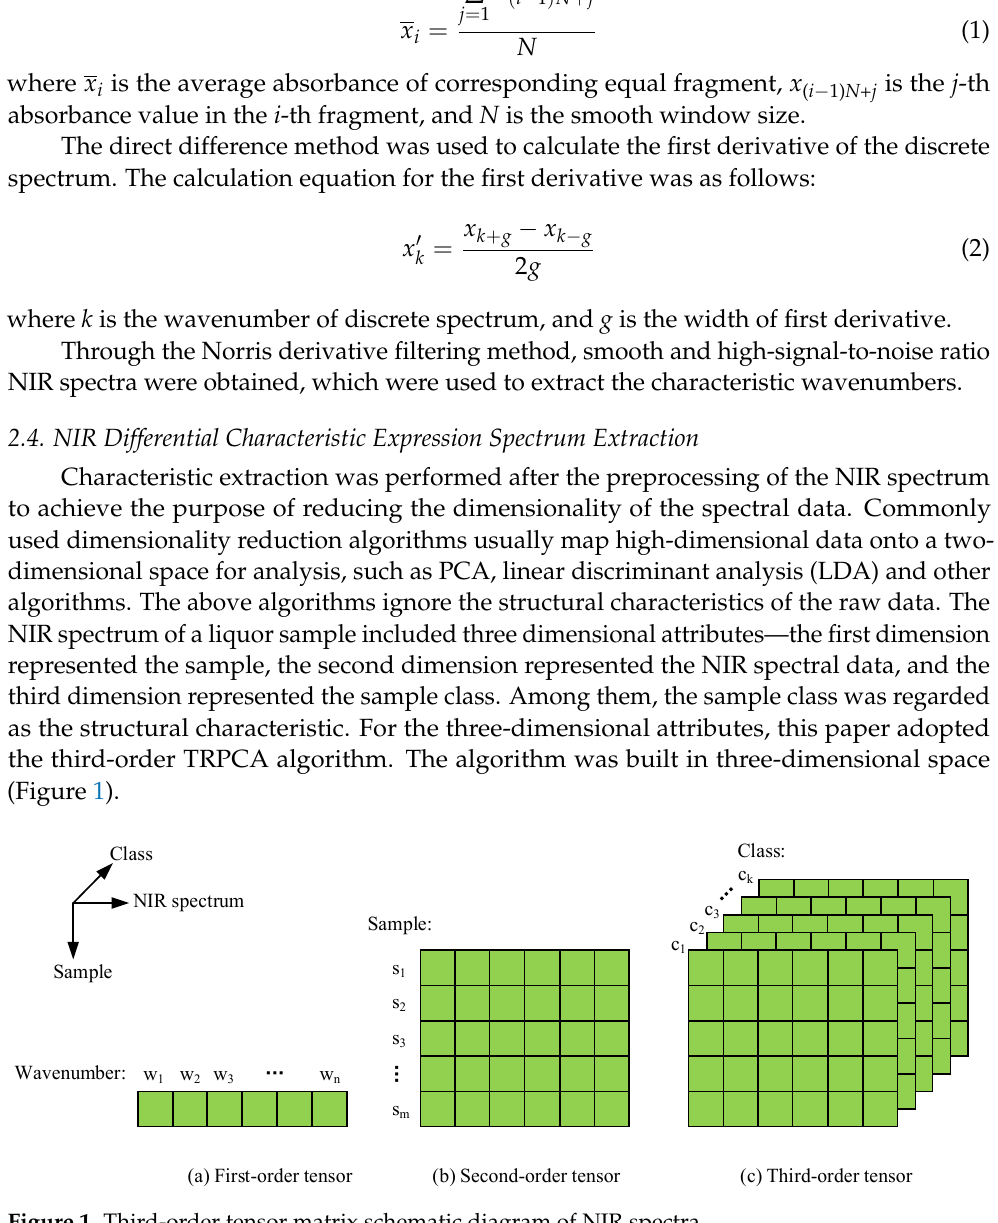
Figure 1. Third-order tensor matrix schematic diagram of NIR spectra.